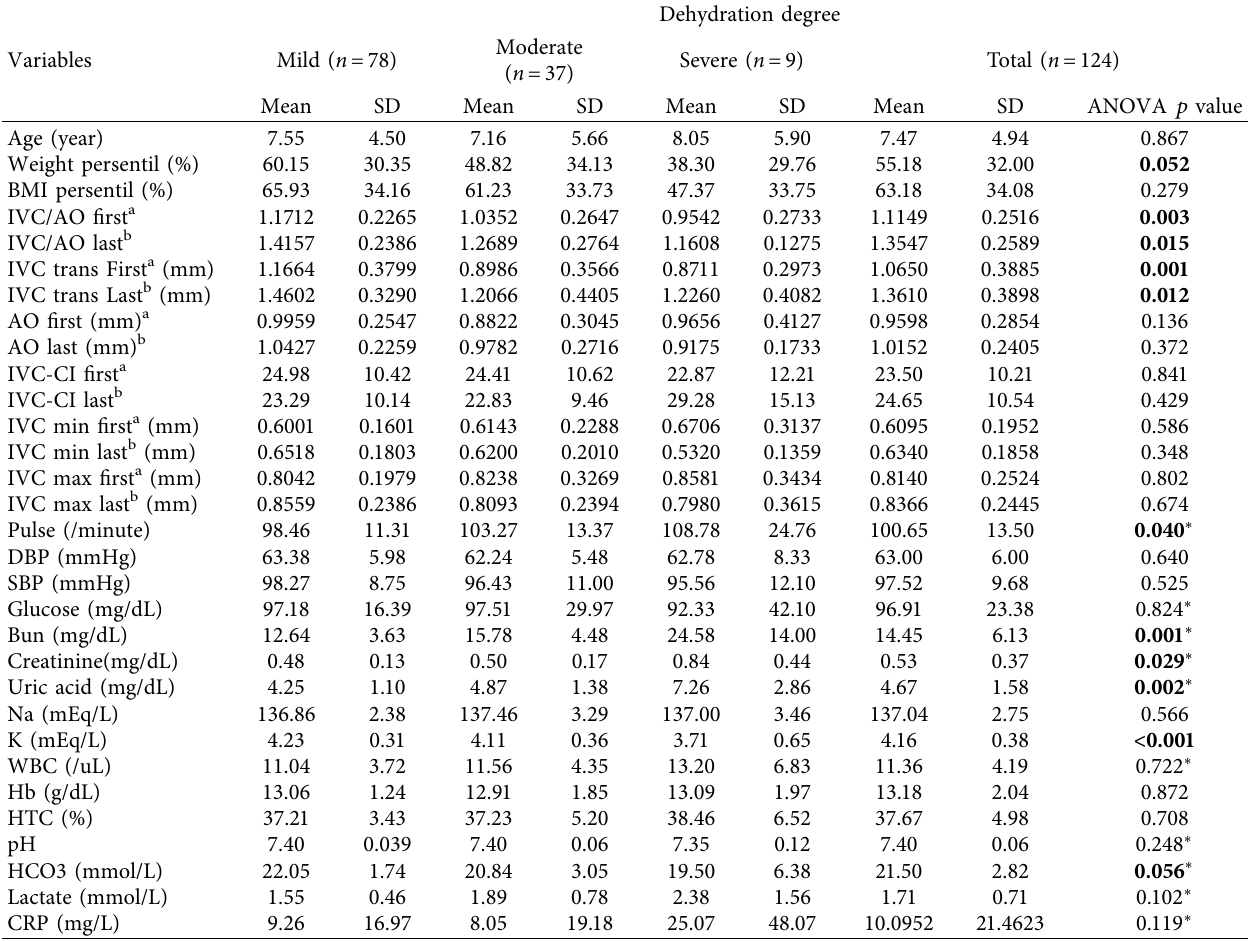
Table 1: Comparison of the demographic characteristics, cardiac and biochemical parameters according to the degree of dehydration